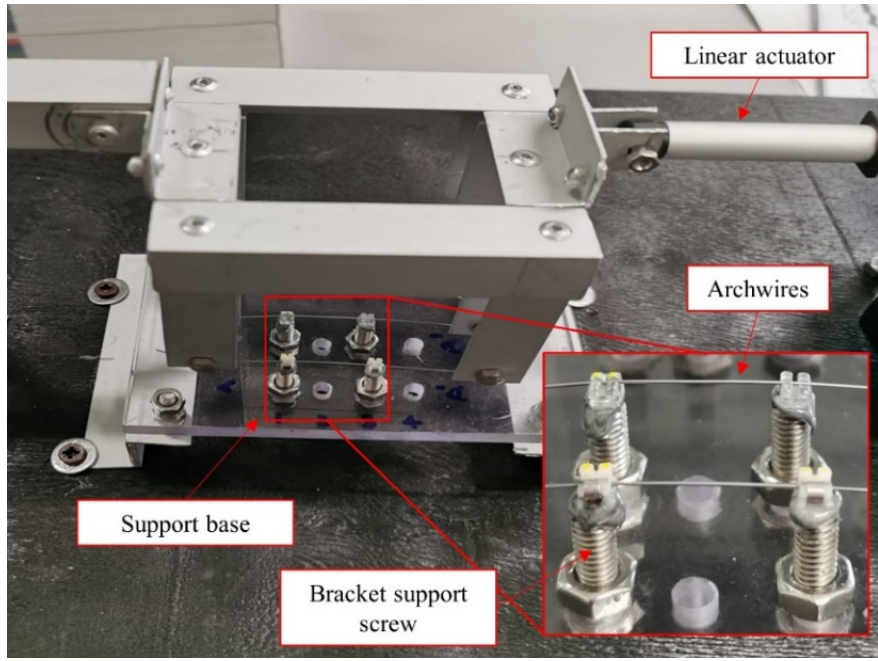
Figure 1. Details of the support base and the screws on which the brackets are